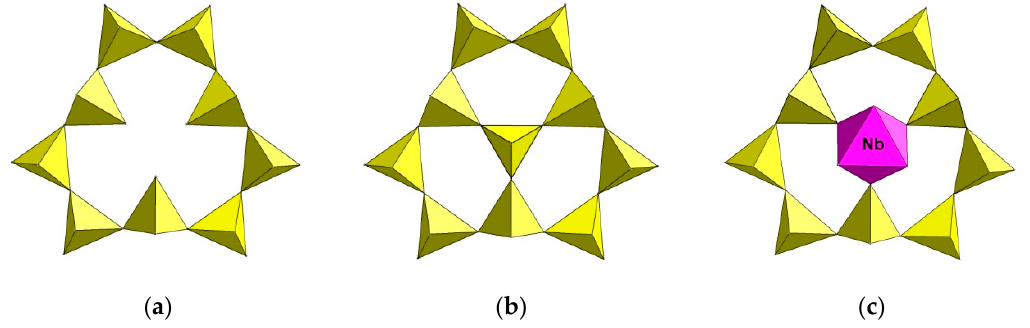
Figure 5. Local situations at the centers of the Si 9 O 27 rings viewed along (001). ( a ) A ring with vacancy at the M 3 site, ( b ) a ring centered with the SiO 4 tetrahedron, ( c ) a ring centered with the NbO 6 octahedron. NbO 6